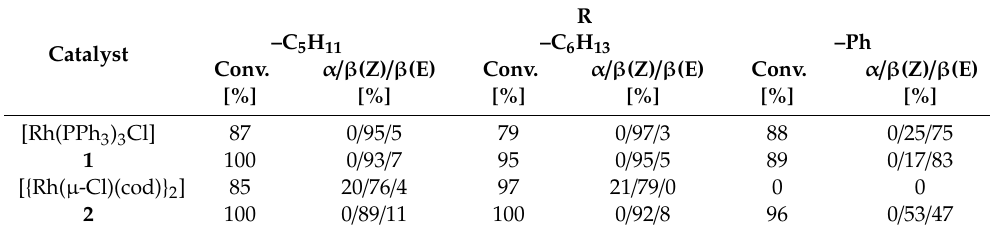
Table 2. The conversion of alkynes and selectivity to isomers in the hydrosilylation of RC ≡ CH with TES.